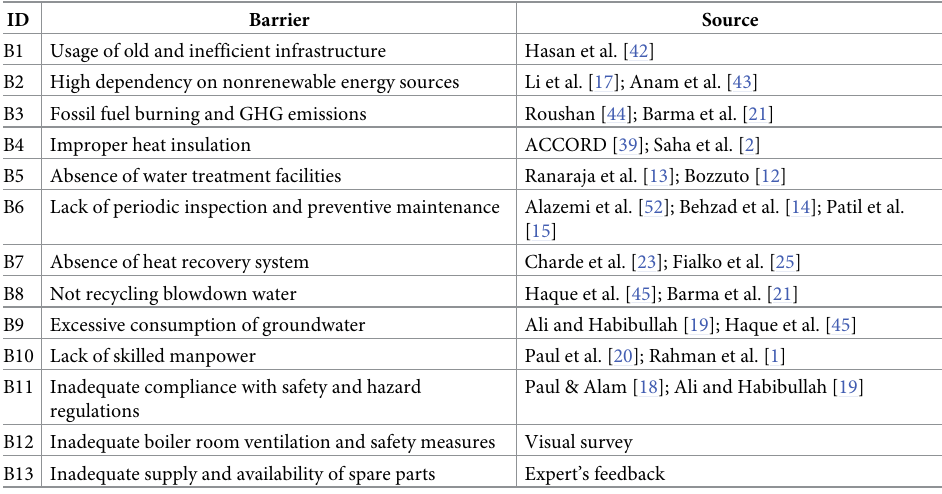
Table 3. Identified barriers to sustainable boiler operation.